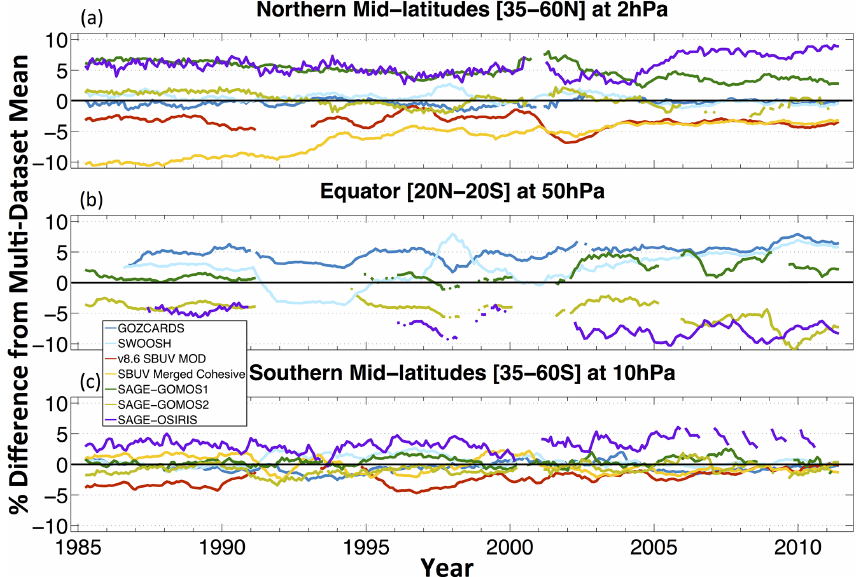
Figure 5. Monthly mean percentage differences from the multi-data-set mean (MDM; see text for details) for (a) the Northern Hemisphere mid-latitudes (35–60 ◦ N) at 2hPa, (b) the tropics (20 ◦ N–20 ◦ S) at 50hPa, and (c) the Southern Hemisphere mid-latitudes (35–60 ◦ S) at